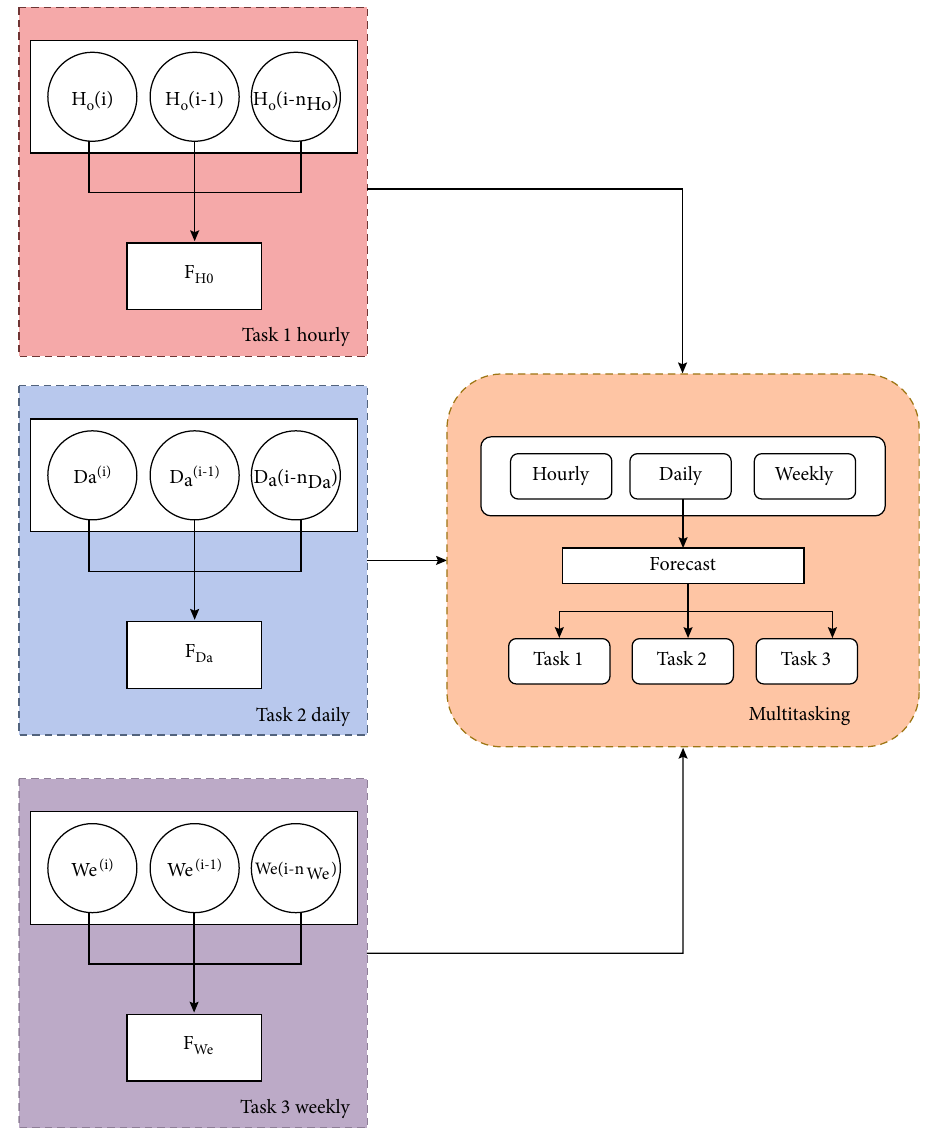
Figure 4: Architecture of the